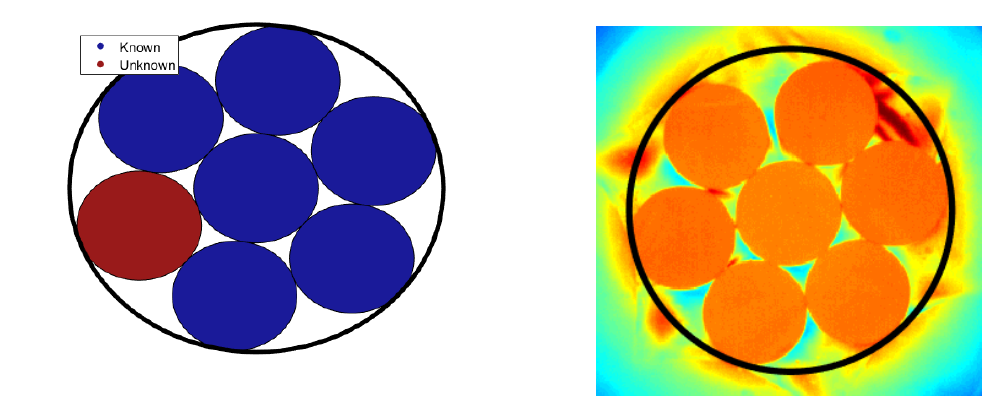
Figure 4. Locations of rods used to train the kernel (train) and the one rod in the test dataset